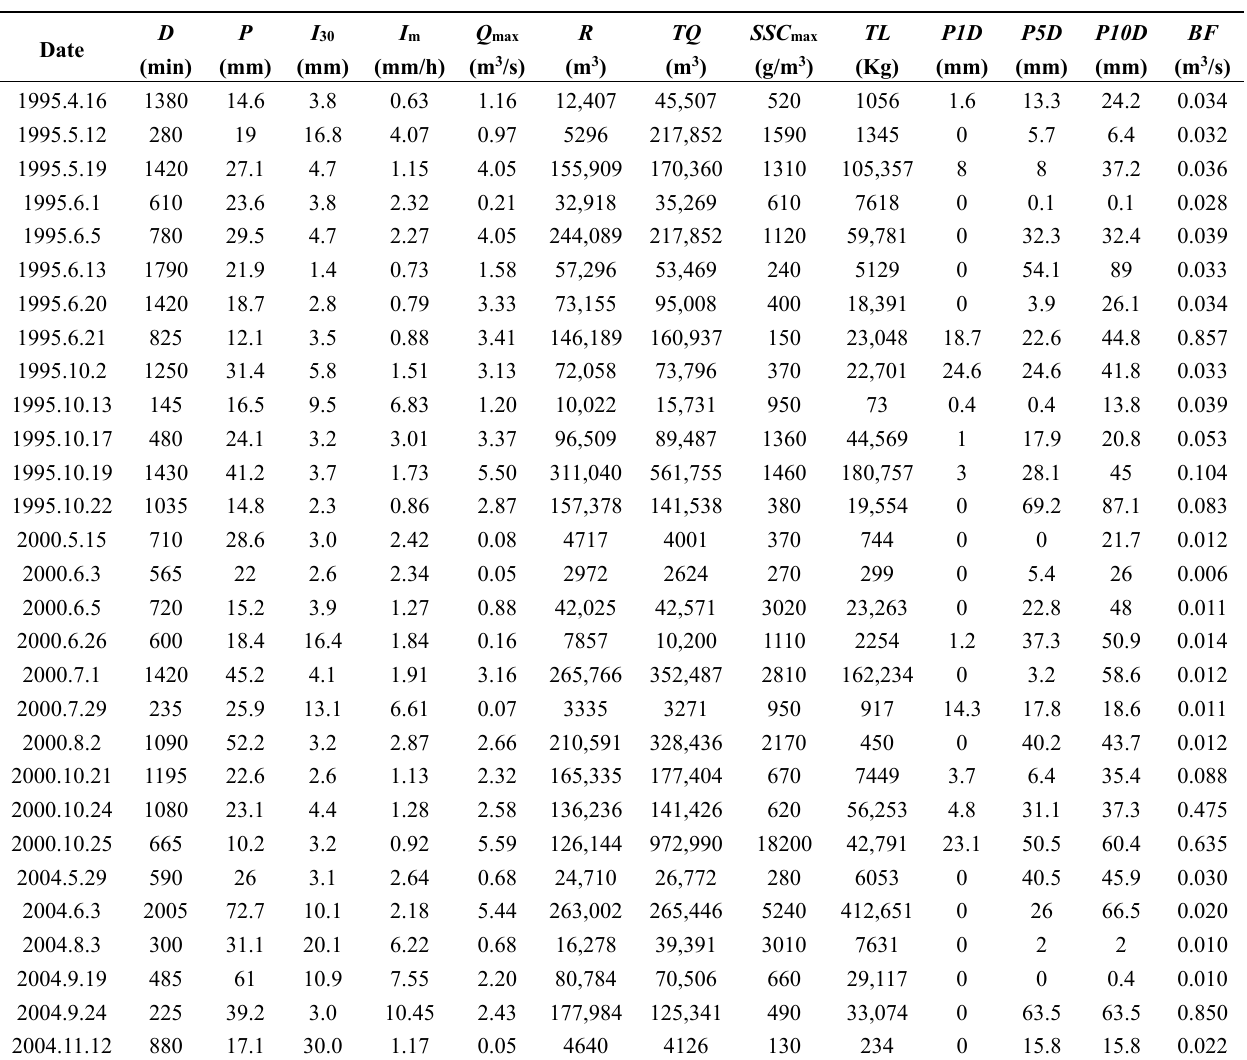
Table 3. General characteristics of the analyzed rainfall-runoff events recorded in the Wangjiaqiao